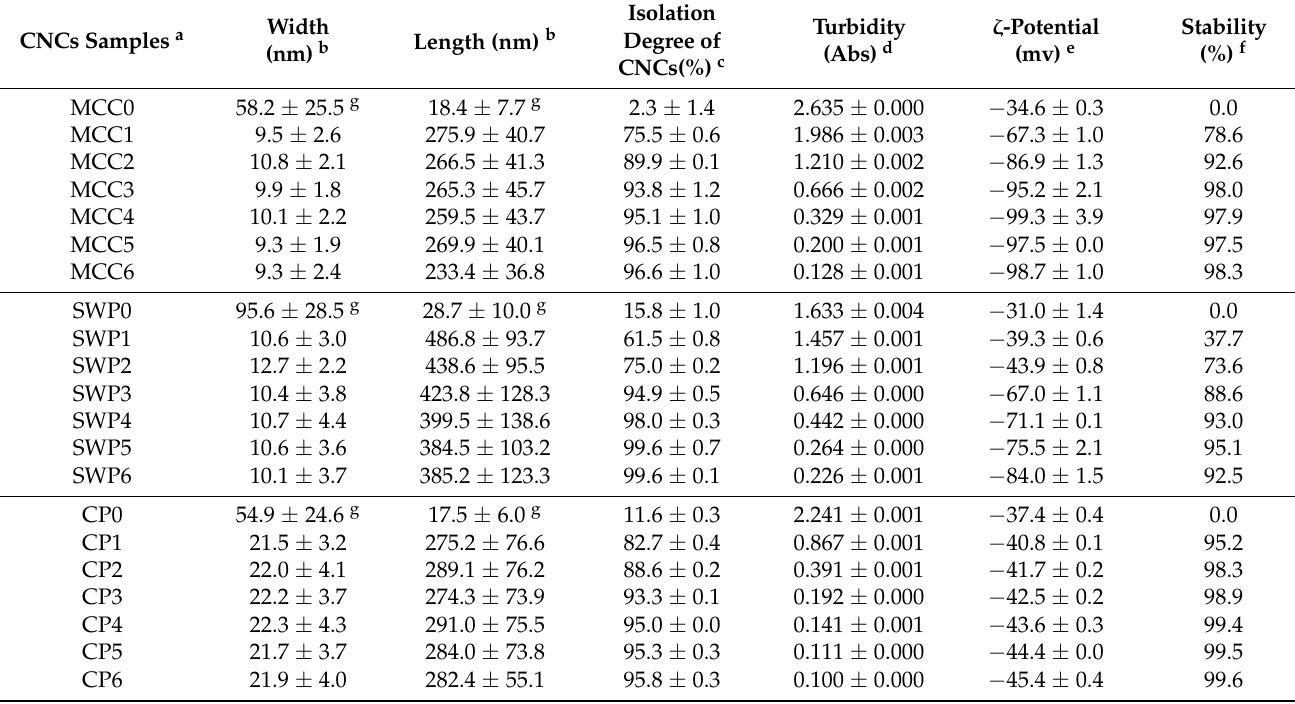
Table 1. Characteristics of CNCs suspensions from diverse cellulosic